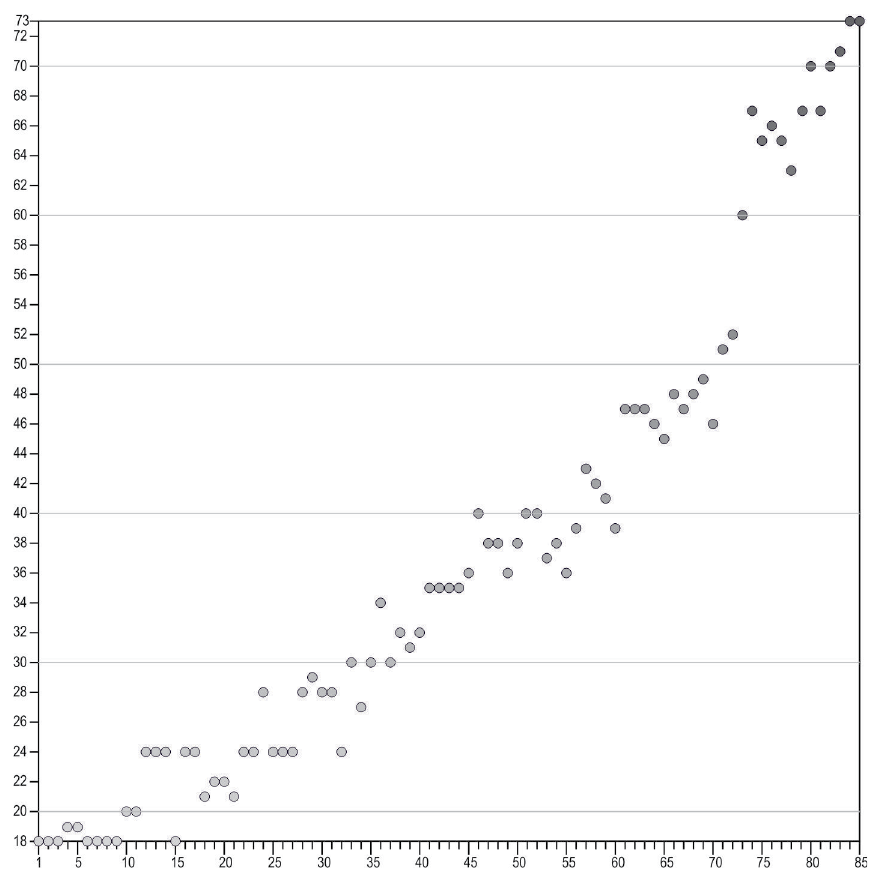
Fig. 3. Graph showing the relationship between the value (shading) of departments’ areas (vertical axis) and the order of statistical data. The horizontal axis shows the departments according to the order of the data, not maintaining the relationship of differences between the statistical